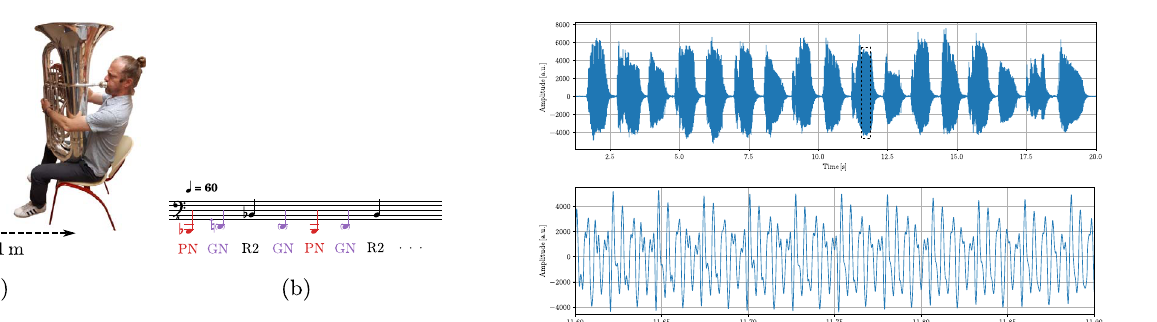
Figure 11. Experimental scheme used to record the profes- sional tuba players (left) and score of the exercise they were asked to play (right), here in the case of the B [ -contrabass tuba. The audio recorder is a Zoom H4n, allowing stereo recording. The recording took place in a semi-anechoic room. (a) Recording scheme. (b) Exercise to play.